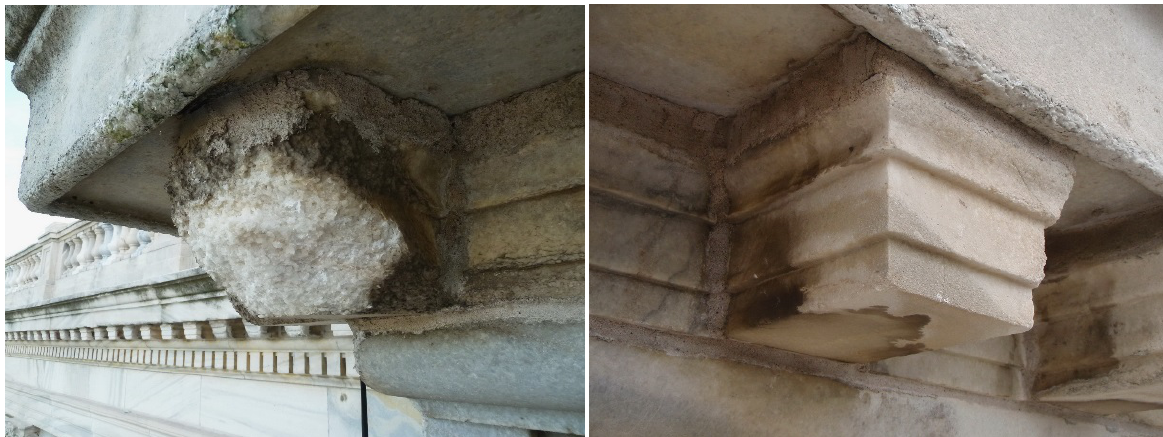
Figure 2: A block modillion of Type 1 marble on the left, with a unit of Type 4 marble on the right for